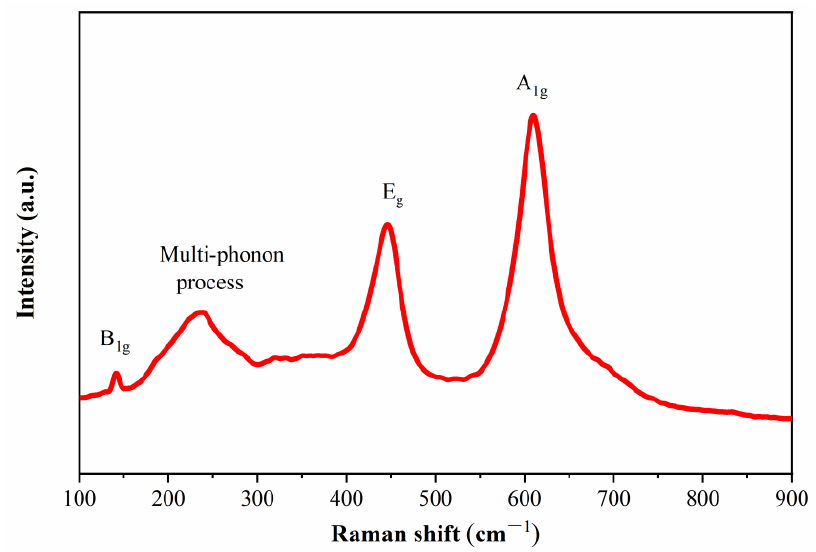
Figure 9. Raman spectra of the sample.